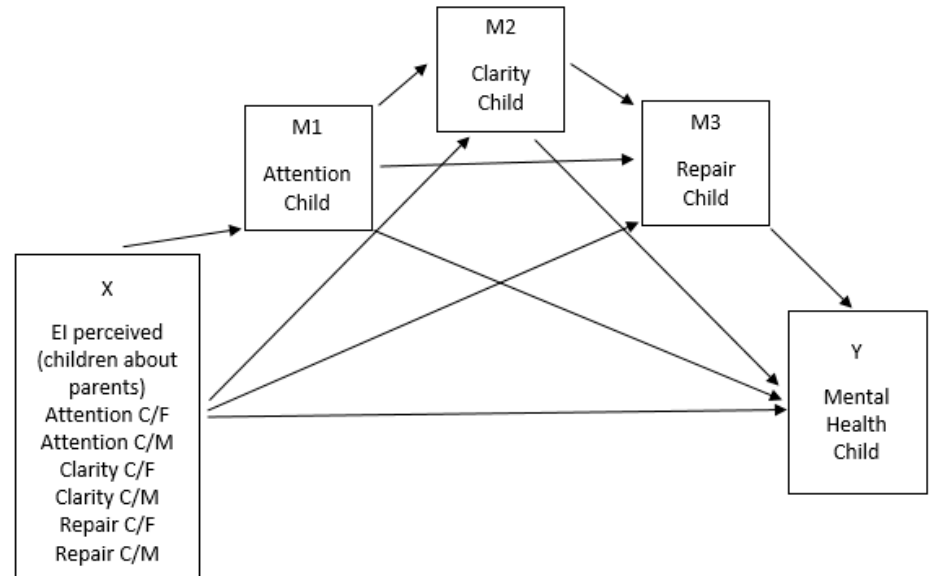
Figure 2. Hypothesized model (H2), (C/F = Children’s perceived EI of their fathers; C/M = Children’s perceived EI of their mothers).